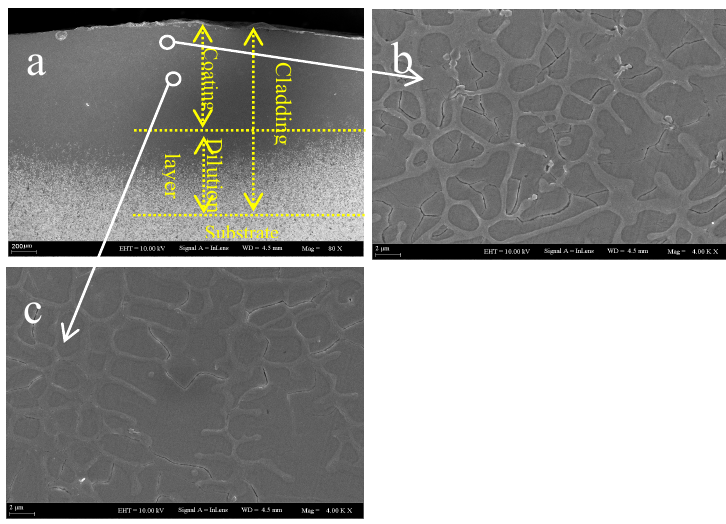
Figure 5. The SEM of longitudinal-sectional microstructure of cladding layer: ( a ) microstructure of cladding layer; ( b ) magnification of the top region; and ( c ) magnification of the middle region.